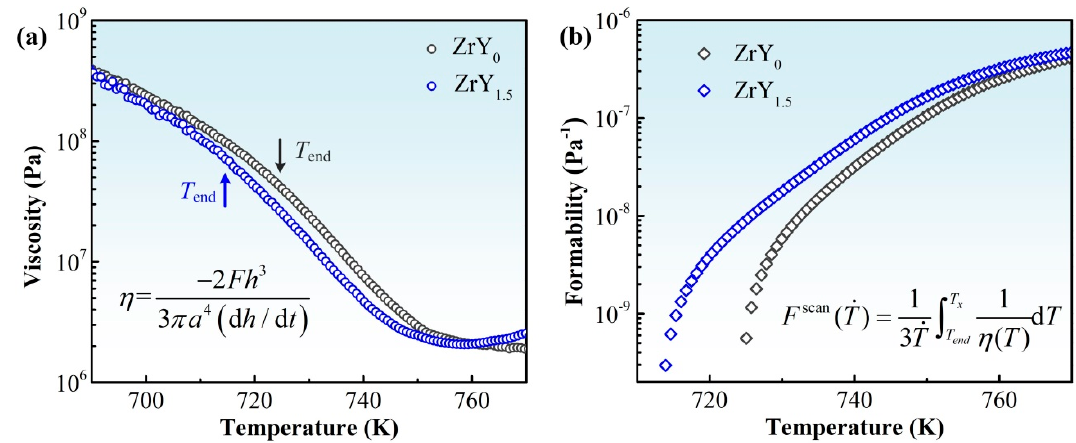
Figure 4. Kinetic properties of the as-cast ZrY 0 BMG and ZrY 1.5 BMG: ( a ) the TMA continuous scanning curves of the two BMGs; ( b ) the quantitative thermoplastic formability.